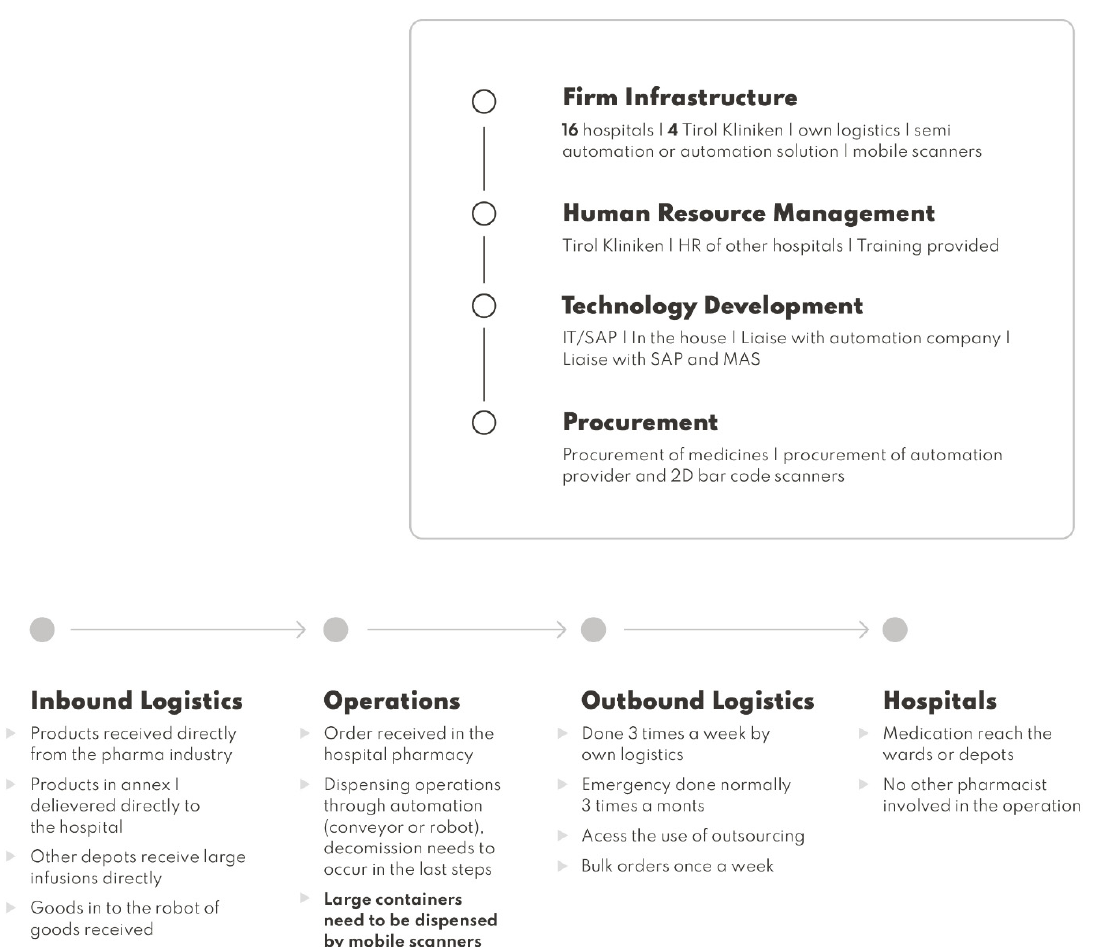
Figure 2. Porter’s value supply chain analysis of the case hospital in a FMD environment.